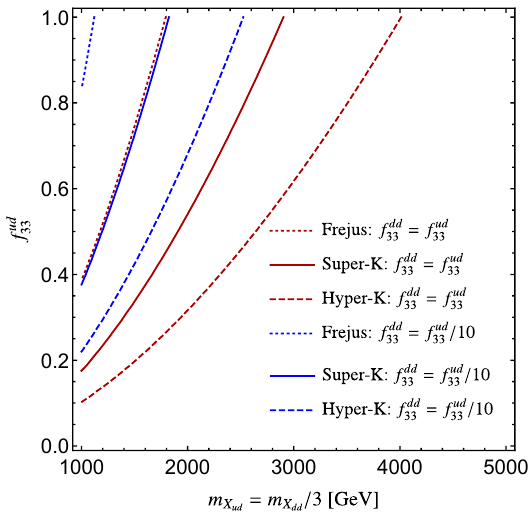
Figure 13 . Contours in the coupling-mass plane demonstrating the potential reach of different dinucleon decay experiments. The red lines correspond to the case f dd = f ud , the blue lines to f ud = 10 f dd .